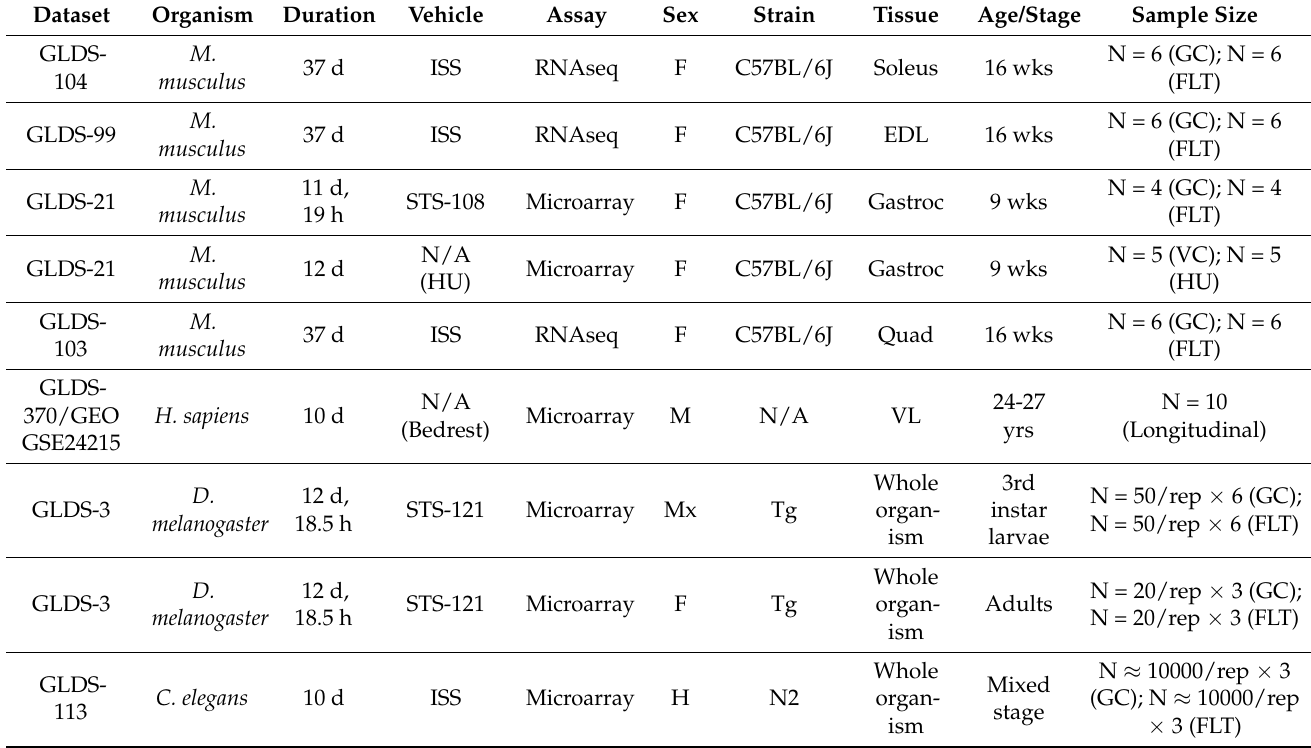
Table 1. Datasets used in the study, including the organism’s name, duration of spaceflight or unloading, assay type, sex, strain, tissue, age, and sample size. Refer to GeneLab and GEO databases for further details. GC: ground control, FLT: spaceflight, VC: vivarium control, HU: hindlimb unloading, Gastroc: gastrocnemius, Quad: quadriceps, VL: vastus lateralis, F: female, M: male, Mx: mixed; H: hermaphrodite. Tg: Gal4-UAS transgenic line expressing two copies of eGFP from the hemolectin promoter. N: number of individuals, rep: replicate of pooled samples run for transcriptomic analysis. Refer to [24,25,37–43] for links to GeneLab processed data and versions used in this